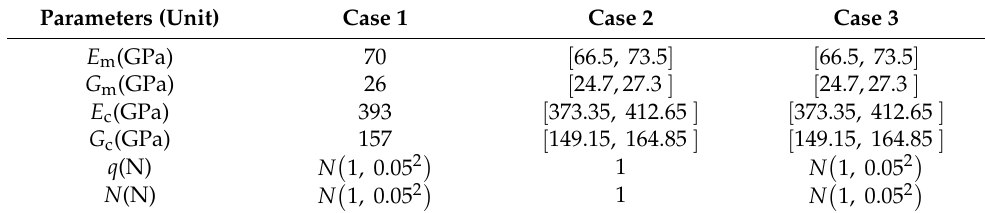
Table 4. Hybrid uncertain parameters for the nanobeam.